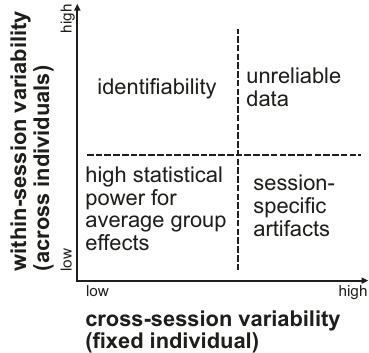
Fig. 1 Individual identi fi ability is a function of individual and session variability in neuroimaging. Consider repeating an experiment in multiple sessions for a group of individuals. Cross-session variability refers to the change in the recorded data for the same individual across sessions, while within-session variability refers to differences in a single session's recorded data across individuals (keeping all other variables, including the stimulus, unchanged). The ideal conditions for the scienti fi c discovery of an effect shared by the group are low within-session and low cross-session variability. However, the combination of low within-session and high cross- session variability indicates an artifact or a confound in the experiment design (e.g., each month, one session is recorded for all individuals and the instrument has a drift over time). High within-session variability paired with low cross-session variability leads to individual identi fi ability with the individual's data acting like a stable signature that differentiates them from others. Finally, high within-session and cross-session variability lead to unreliable